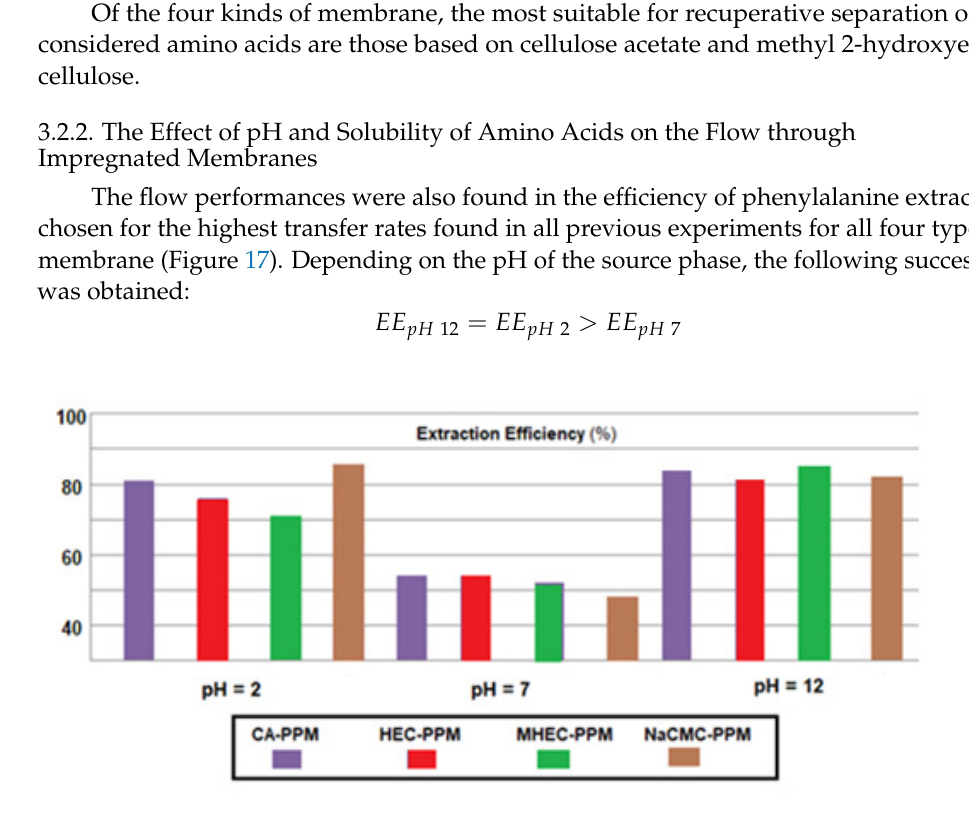
Figure 18. The phenylalanine extraction efficiency EE (%) variation versus the temperature of source phase (SP) for the prepared membranes. The transfer rate of alanine is lower in all cases, remaining in high concentration in the source phase. This observation suggests the possibility of separating the three chosen amino acids by the appropriate choice of the cellulosic derivative. Thus, phenylalanine and methionine can be recovered from the receiving phase and alanine is concentrated in the source phase. One explanation that would answer to the results presented in Figures 13–15a would be that the solubility of alanine is much higher than that of the other two amino acids (Table 3), which would lead to an important retention of it in the source phase.